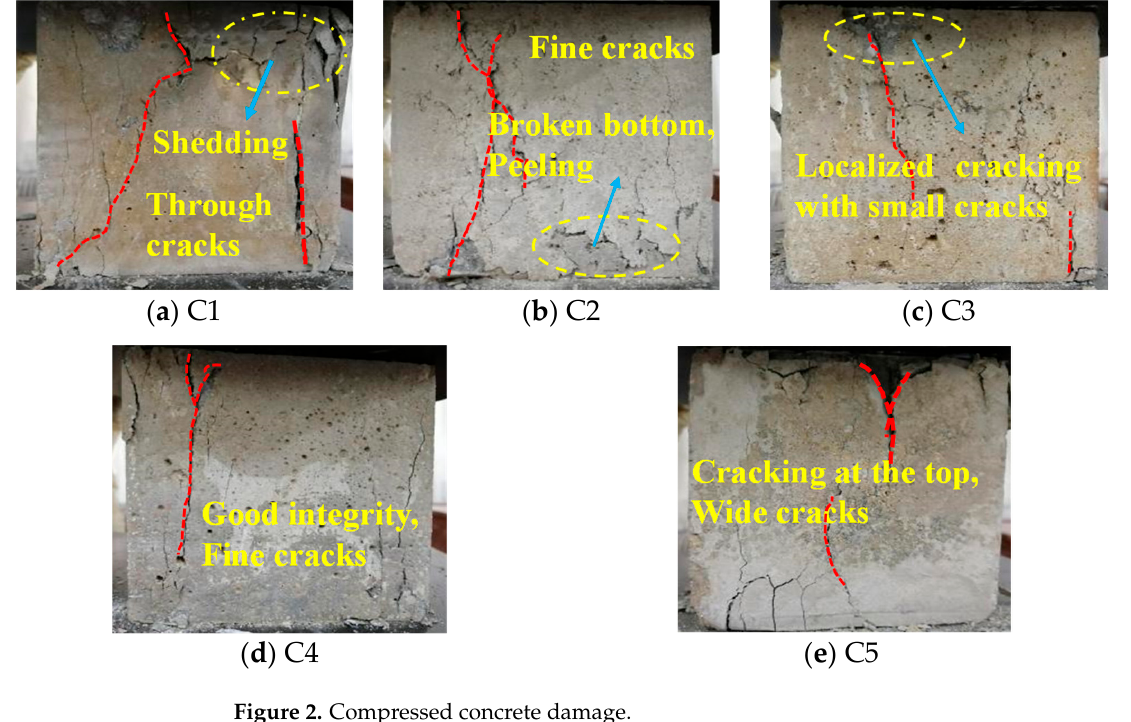
Figure 2. Compressed concrete damage.